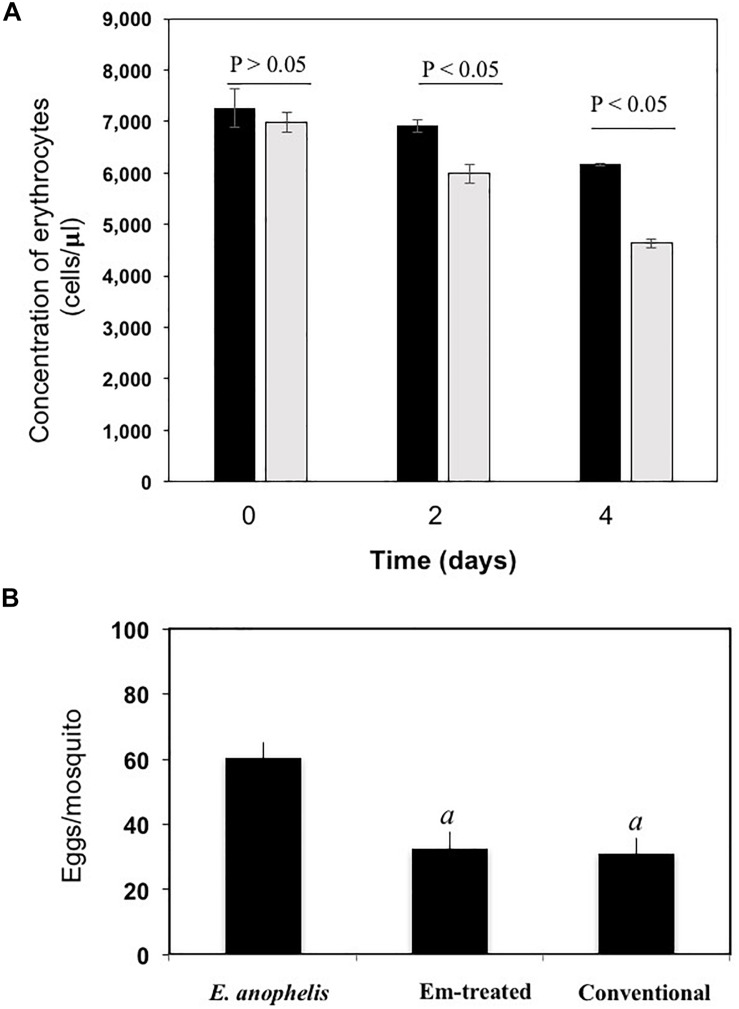
Effects of added E. anophelis cells on red blood cell lysis and mosquito fecundity. (A) Time course of the digestion of red blood cells by E. anophelis. Values are means ± standard deviation. Comparisons that were significantly different (P < 0.05) were concentrations of red blood cells incubated without E. anophelis addition on day 2 and day 4 versus day 0 or incubated with E. anophelis on day 2 and day 4 versus day 0, respectively. (B) Fecundity of A. stephensi after a bovine blood meal given by membrane feeding. Comparisons that were significantly different (P < 0.05) were the eggs produced by mosquitoes previously provided E. anophelis in a sugar meal, E. anophelis in sugar meal supplemented with erythromycin versus sugar only (indicated by “a”), respectively.